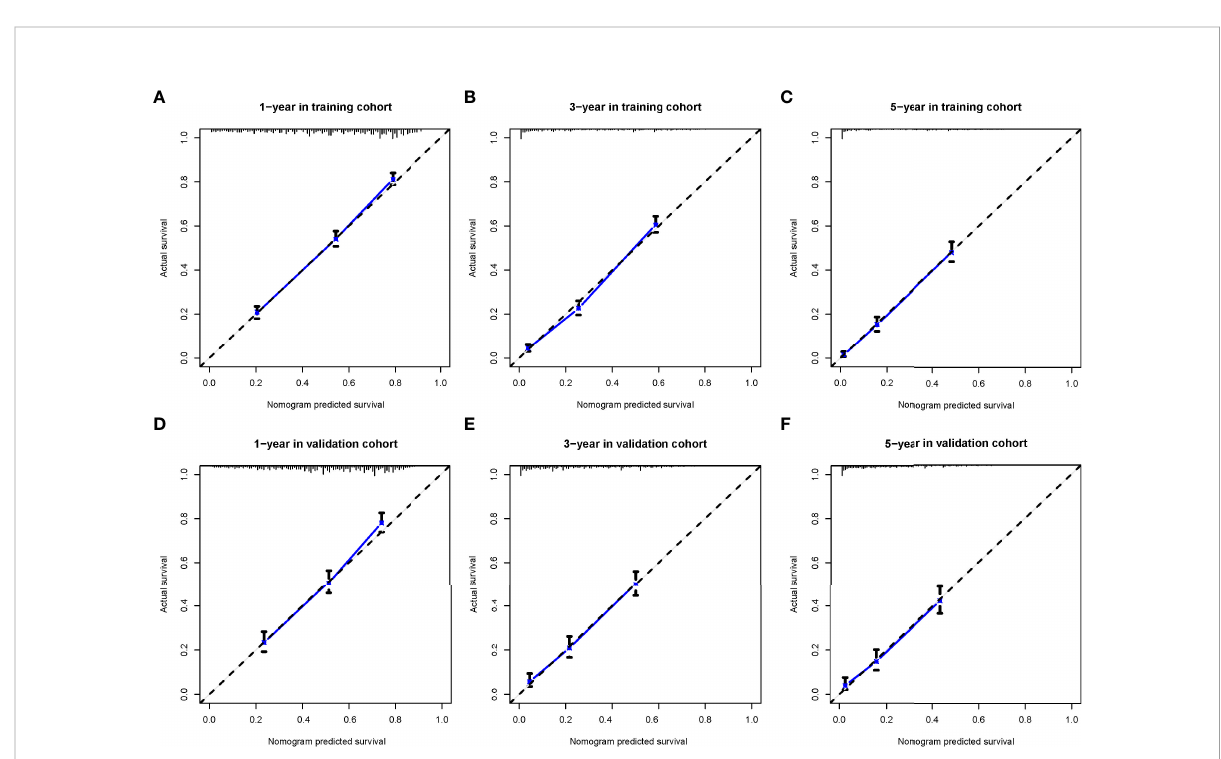
FIGURE 4 The calibration curves for predicting patients ’ overall survival in the training cohort (A – C) and validation cohort (D – F) at 1-year, 3-year, and 5- year,